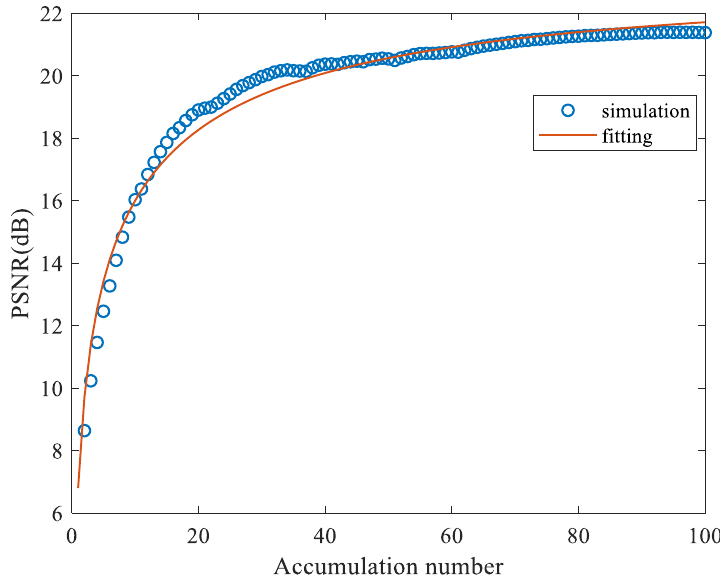
Figure 7. PSNR of the reconstructed image by LRDS binary CGHs ( k = 4) together with AIA as a function of accumulation number. The values of the parameters ( S , K ) of the fitting curve are (2.24, 42.4).